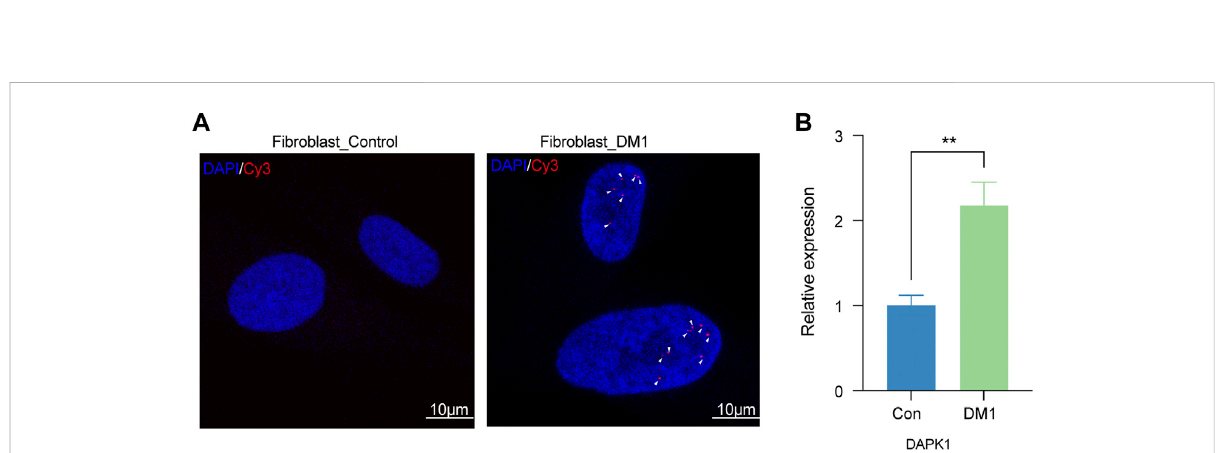
FIGURE 6 Validation of DAPK1 in vitro . (A) Representative image of Myotonicdystrophy type 1 (DM1) and healthy control fi broblast stained for RNA foci by fl uorescent in situ hybridization (FISH). Arrowheadsindicate multiple RNAfoci(red color) in nuclei of DM1 fi broblast(scale bar = 10 μ m). Nuclei were counter-stainedwithDAPI(bluecolor). (B) ThedifferenceexpressionlevelsofDAPK1byRT-PCRbetweenDM1( n =3)andcontrol fi broblasts( n =3), ** p <